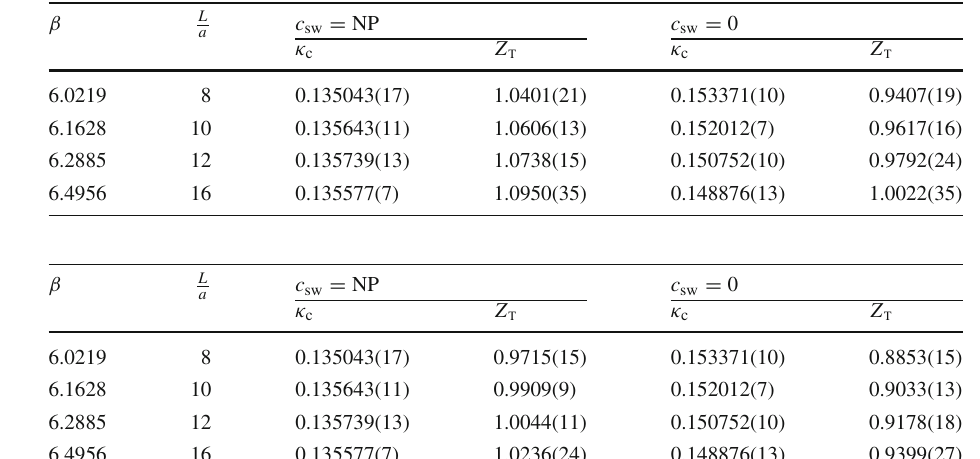
constants Z T ( g 2 L = 1 /μ α = 0